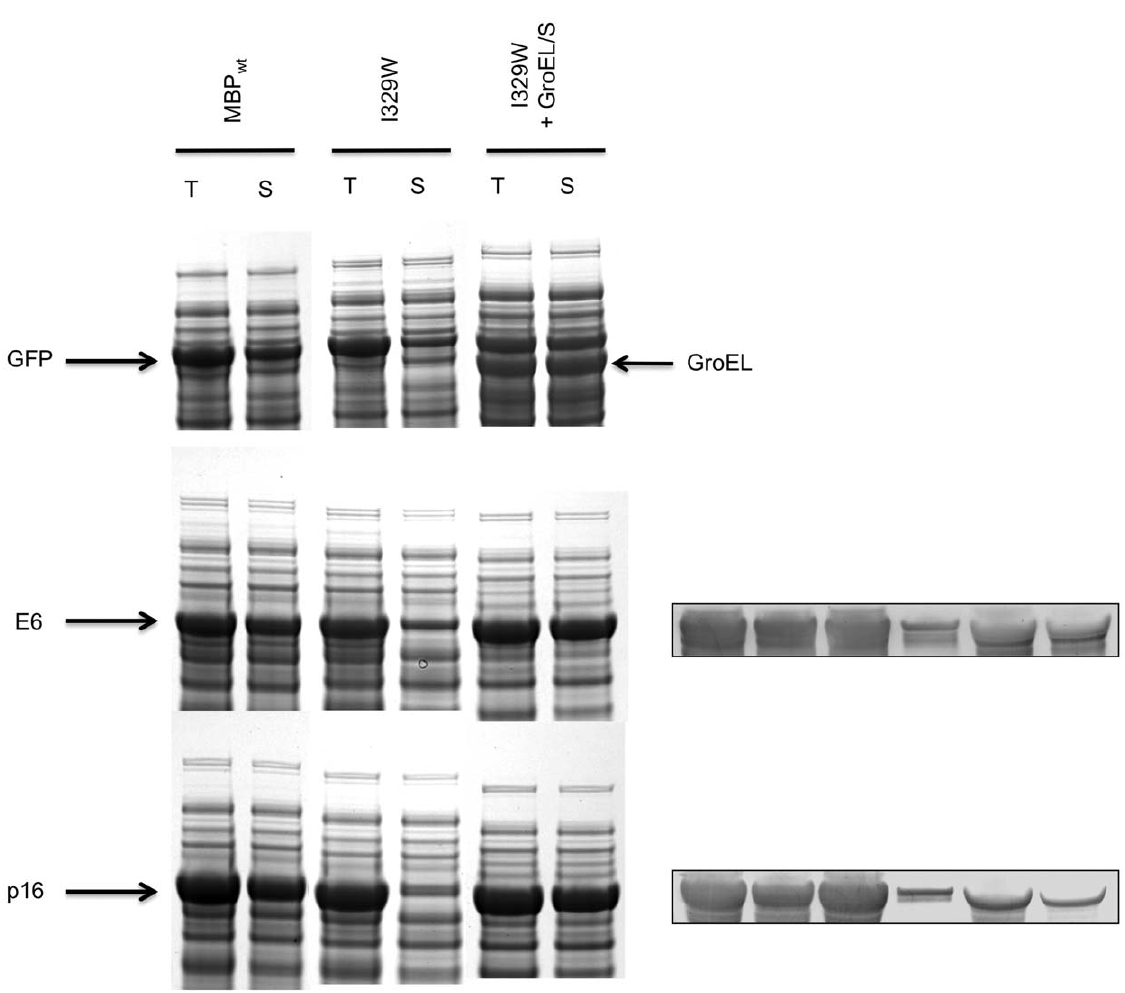
Figure 6. Overproduction of GroEL/S rescues the solubility defects of some MBP fusion proteins. Expression and solubility of wild type MBP (MBP wt ) and mutant MBP (I329W) fusion proteins are shown in the figure. The co-expression of GroEL/S along with mutant MBP fusions rescues the solubility (right most pair of lanes). The passenger proteins were GFP (top), E6 (middle) and p16 (bottom). A Western blot using anti-His 6 tag antibody is shown to the right since the fusion proteins and GroEL co-migrates in the case of E6 and p16 (MBP fusion proteins carry a His 6 tag at the N-terminus); loading is similar to the respective gels on the left.